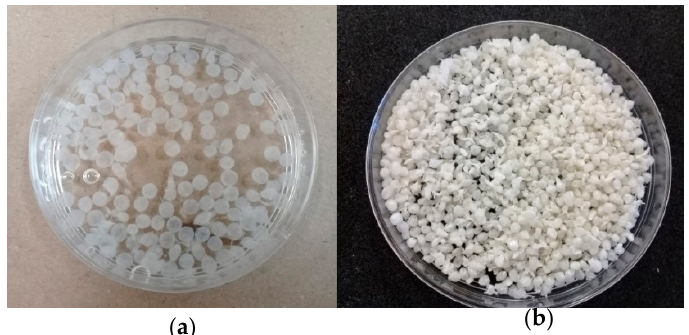
Figure 1. Physical appearance of synthesized cross-linked chitosan-based beads: ( a ) fresh composites, and ( b ) lyophilized composites.